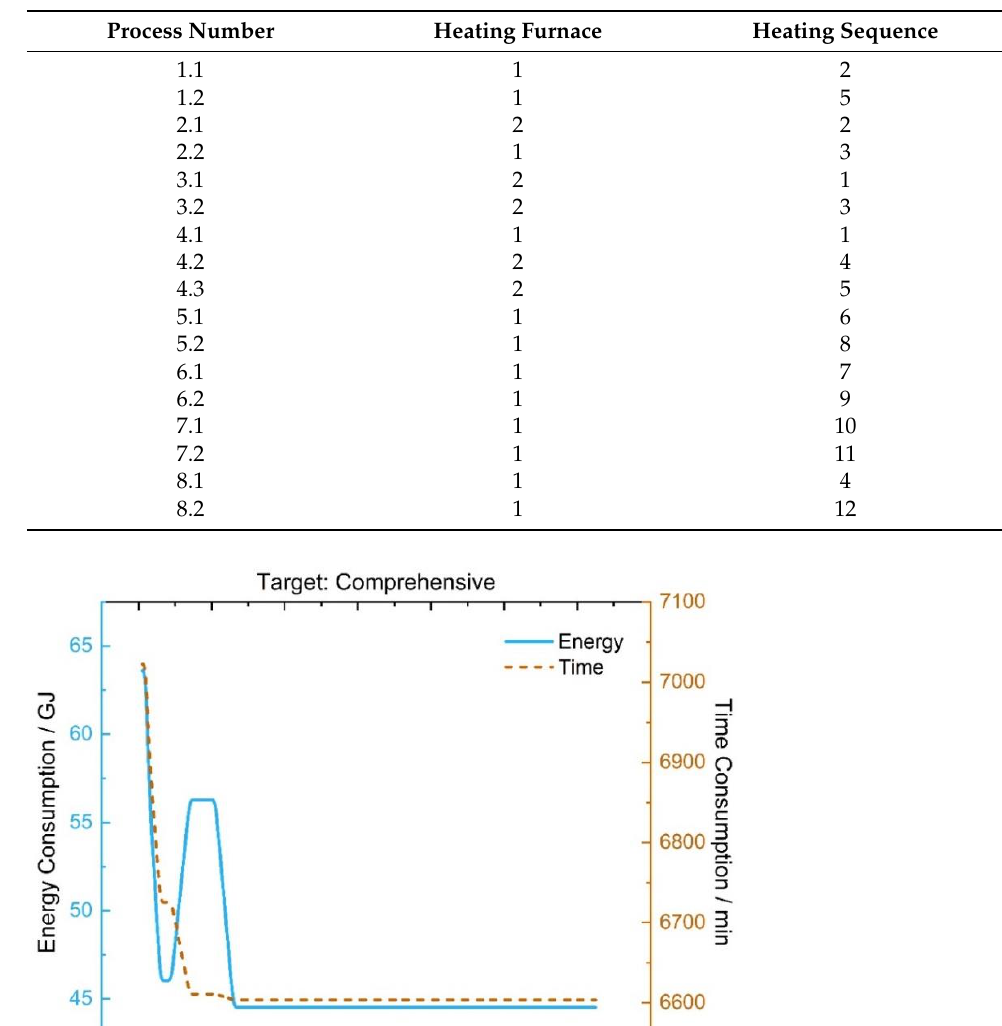
Table 6. Batch 1 final optimization result.